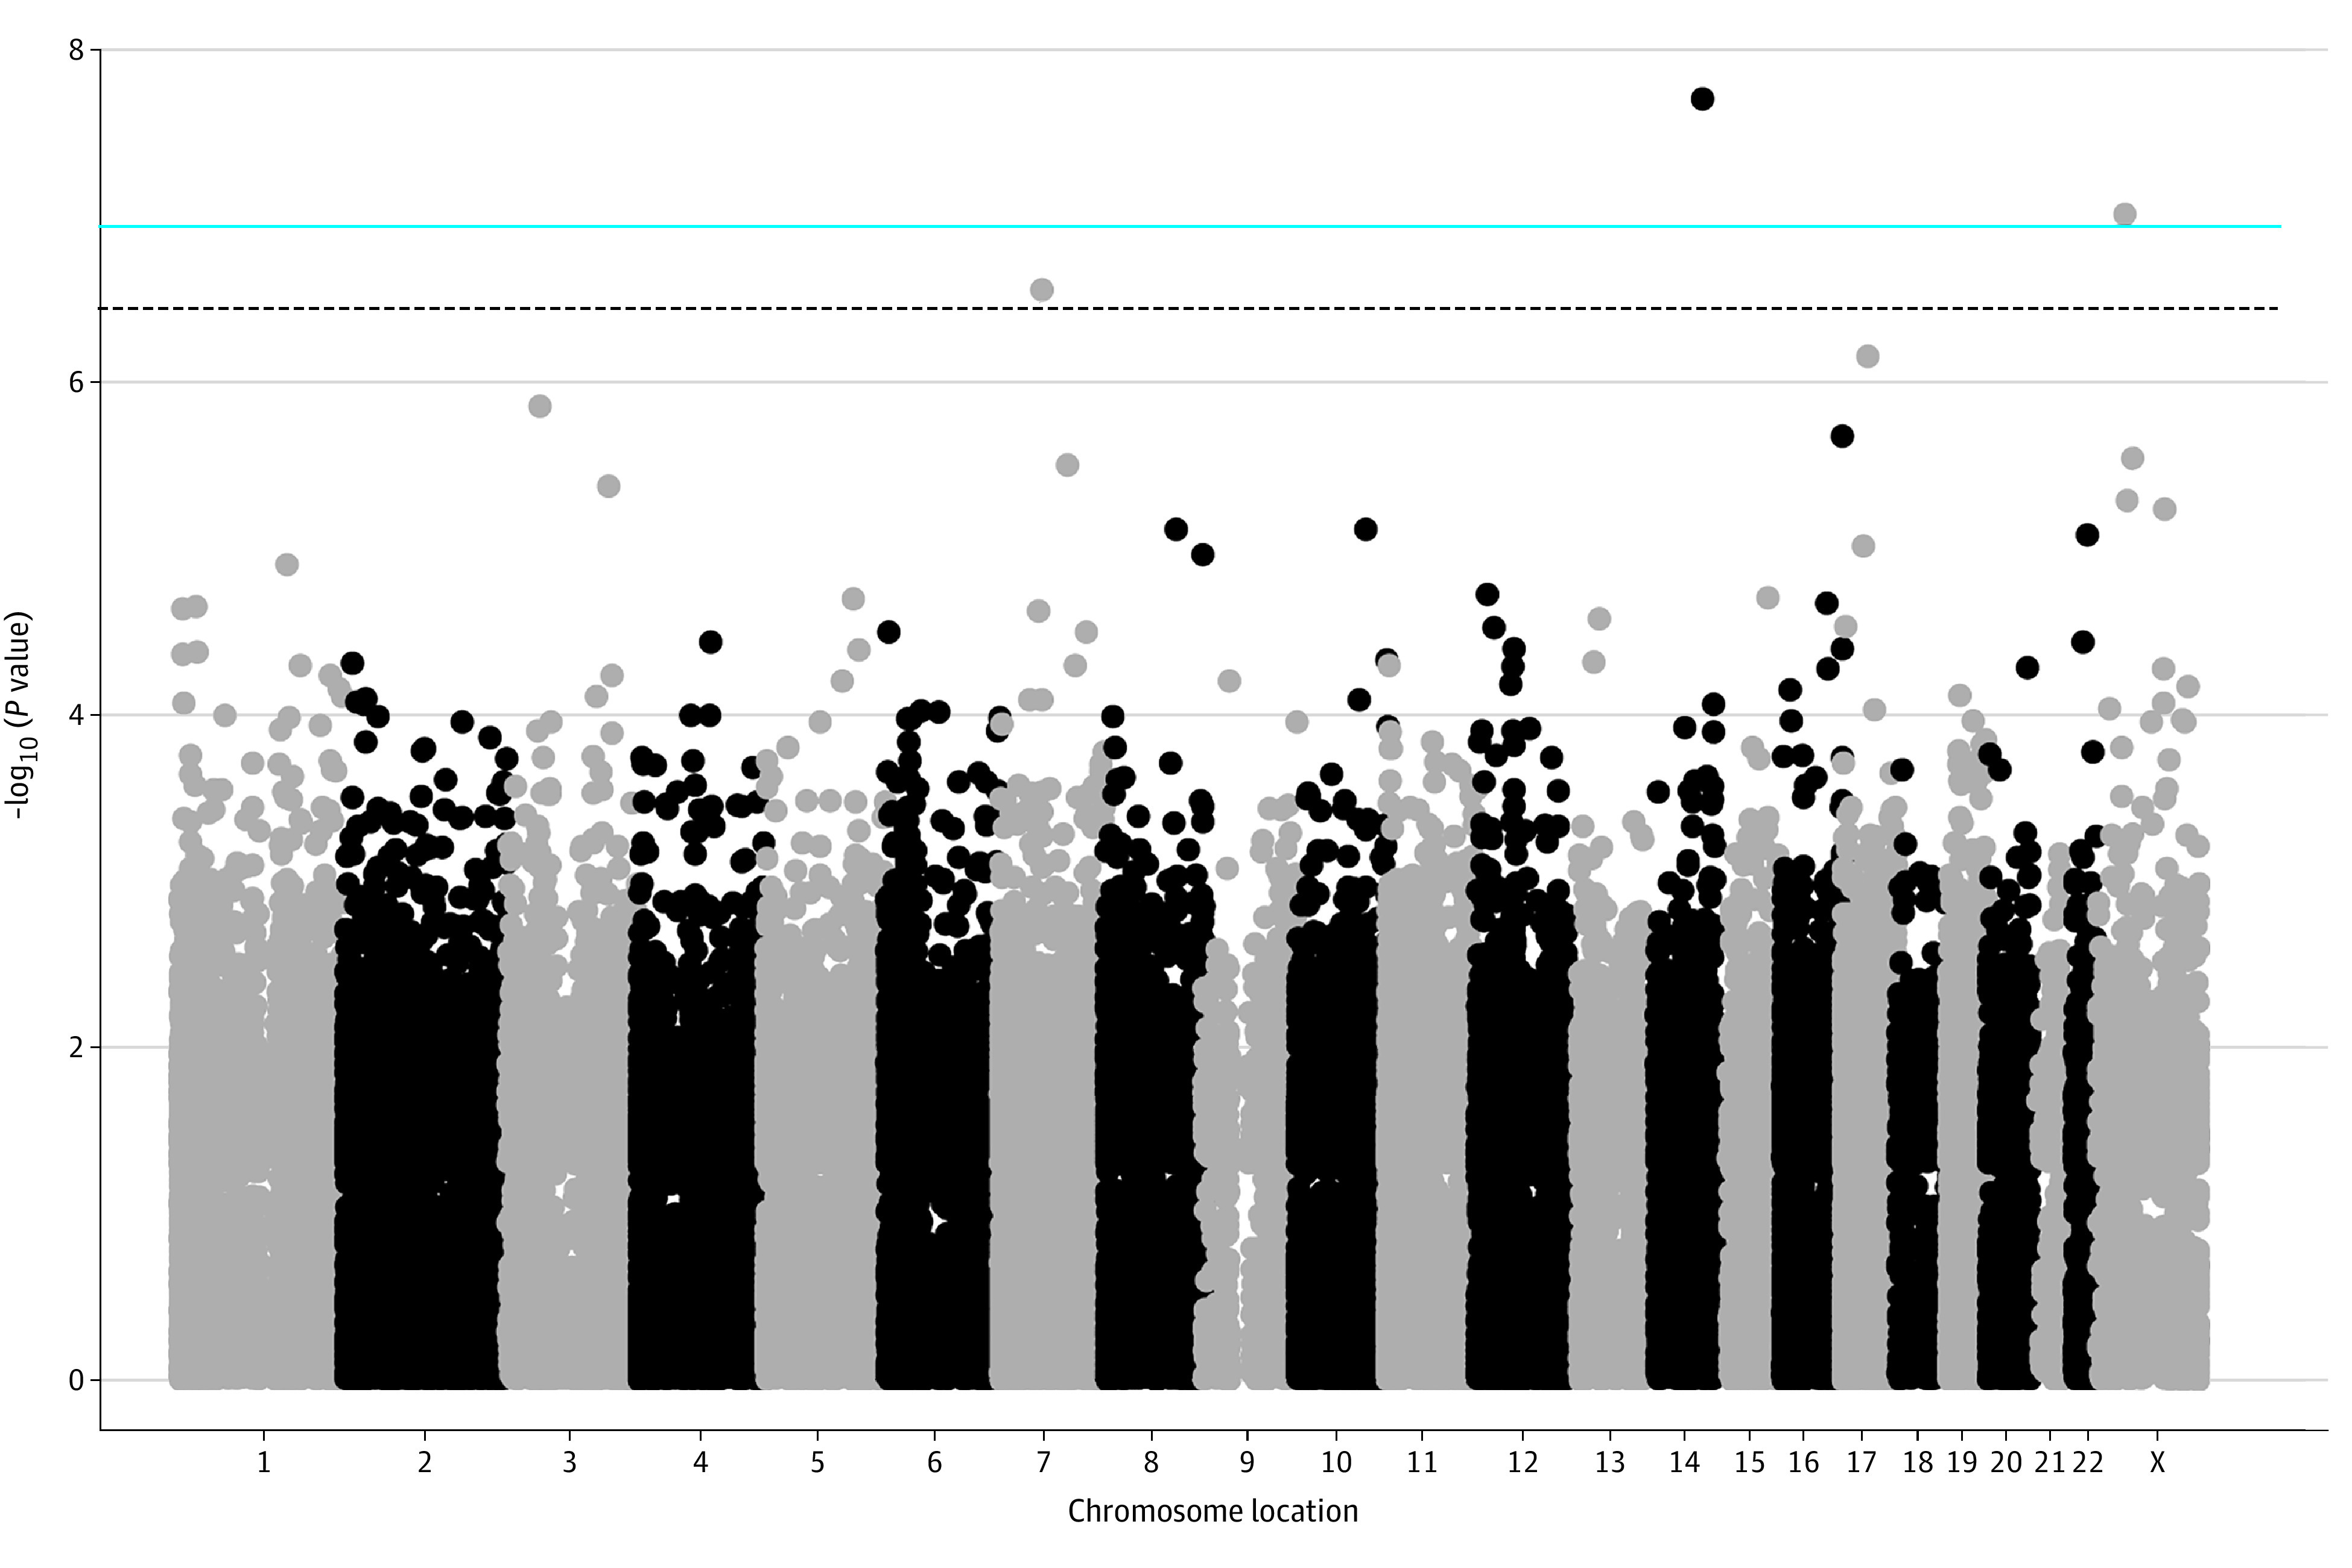
Manhattan Plot for Epigenome-Wide Association With Area Deprivation Index